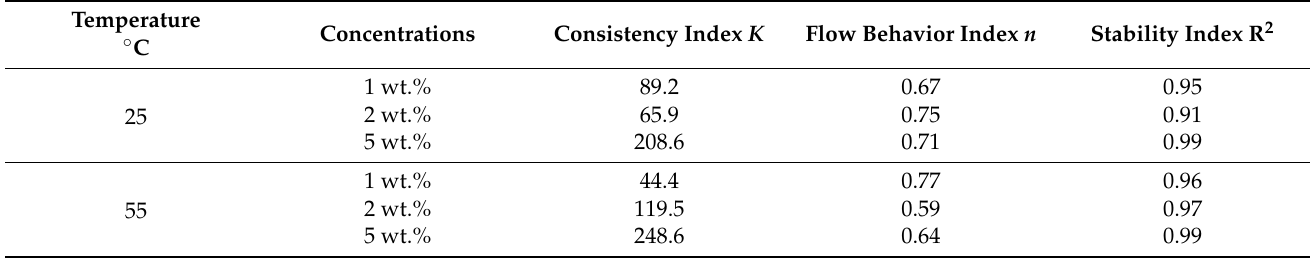
Table 1. Ostwald–de Waele power-law model at different